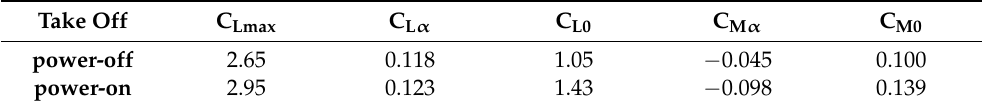
Figure 23. Vorticity scene with the body skin friction contour and plot of pressure coefficient for sections located behind the propeller, AoA = 10 deg, take-off power-on, M = 0.15, Re = 5.7 × 10 6 , J TIP = 0.78, rpm TIP = 1600, J DEP = 0.89, rpm DEP = 2000. Table 15. Numerical results for take-off power-on condition, untrimmed maximum lift coefficient, moment coefficient calculated w.r.t. CG pos. (31% mac), M = 0.15, Re = 5.7 × 10 6 , J TIP = 0.78, rpm TIP = 1600, J DEP = 0.89, rpm DEP = 2000. Take Off C Lmax C L